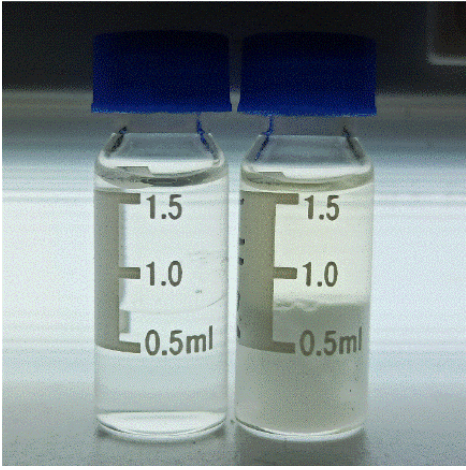
Figure 4. The extraction systems: based on isopropyl salicylate in heptane on the right and with addition of TOPO on the left.